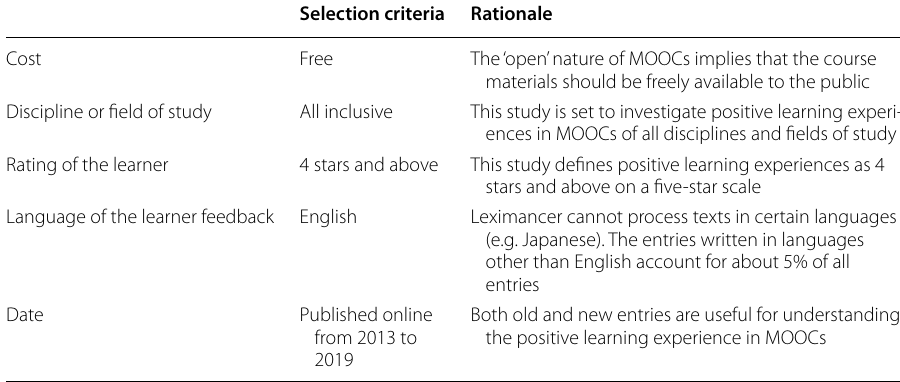
Table 1 Selection criteria for entries Selection criteria Rationale